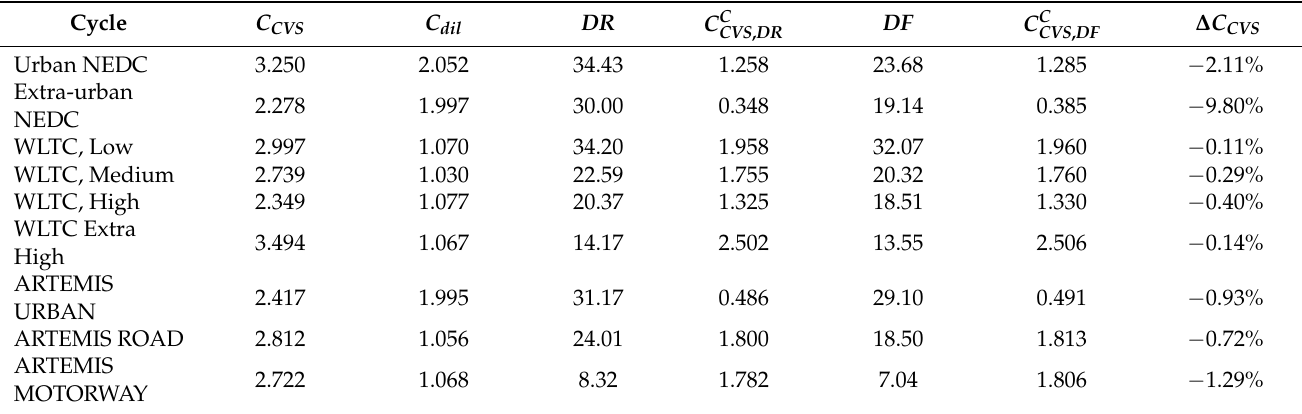
Table A15. The C CVS,corr calculated based on Equations (5) and (21) for Euro 6 WLTP vehicle with SI engine, CH 4 concentration